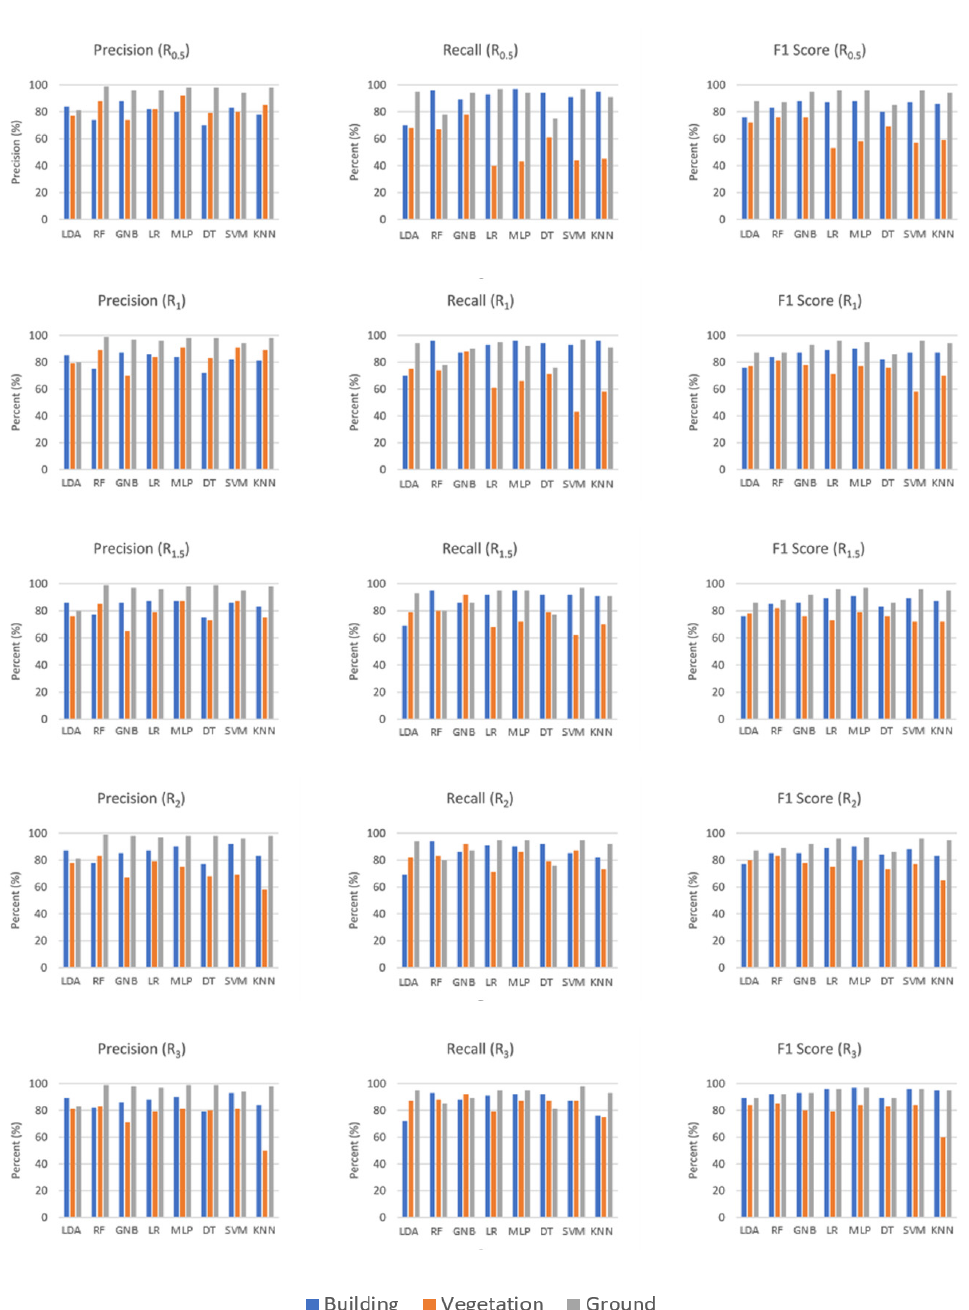
Figure 13. Precision, recall and F1 score values of the algorithms for Dublin City Area 2.